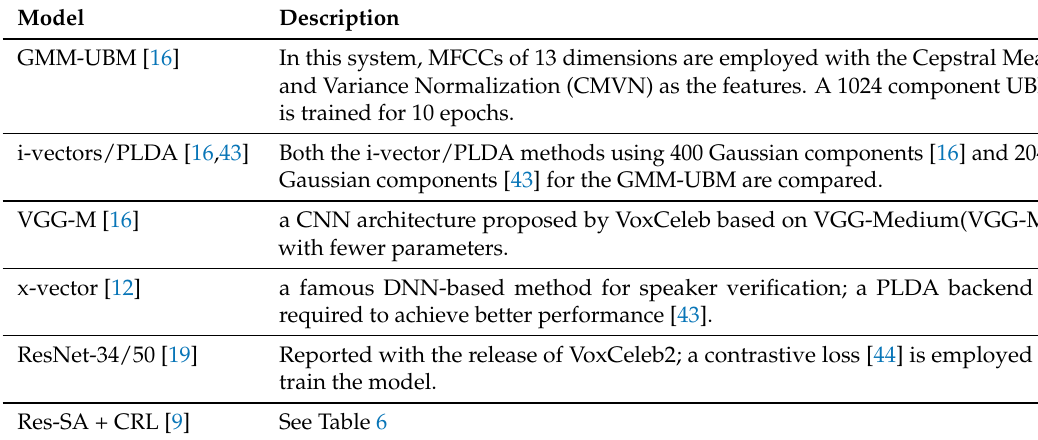
Table 12. Different baselines for speaker verification. UBM, Universal Background Model; CRL, Cluster-Range Loss.